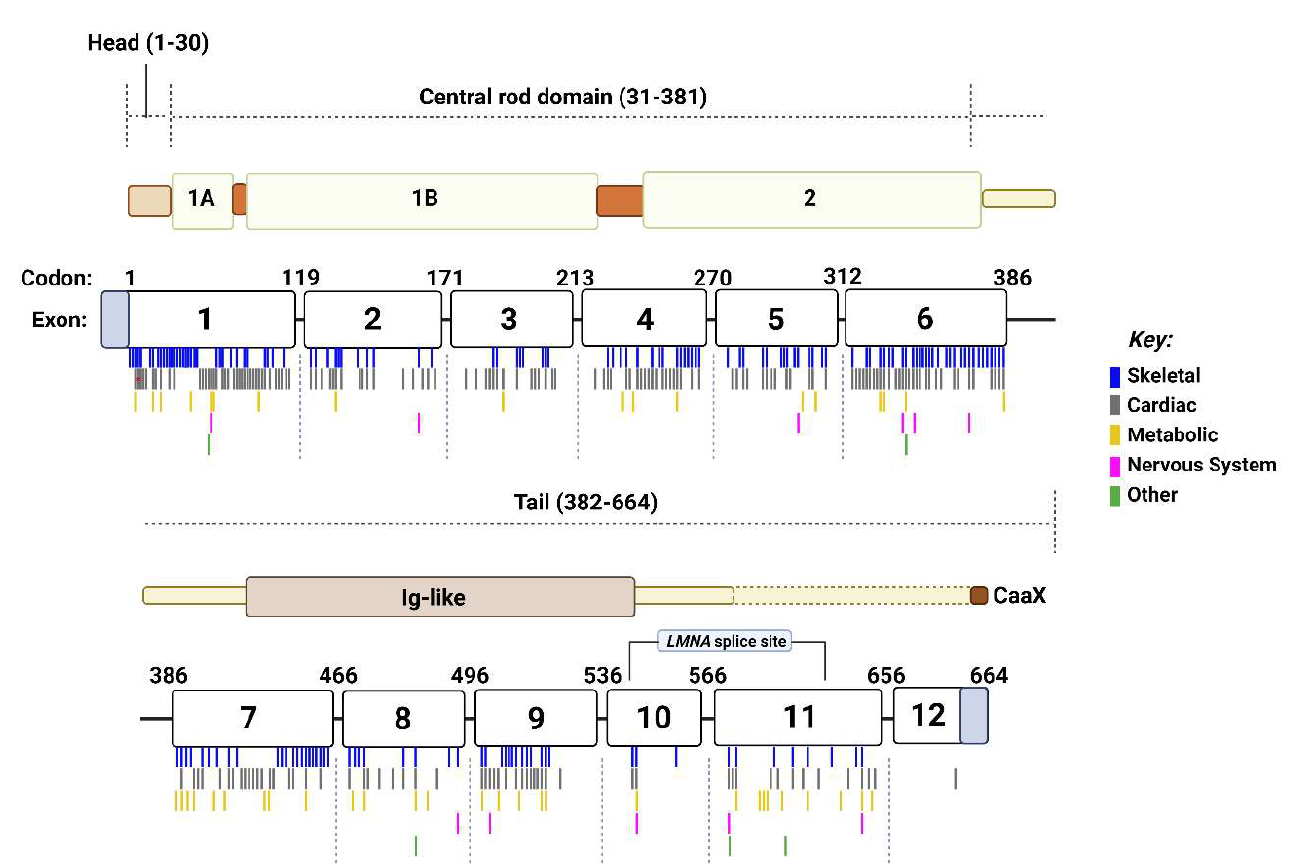
Figure 4. The structure of the LMNA gene and protein product lamin A. LMNA encodes lamin A/C. Lamin C is produced via a splice site located at intron 10 and therefore it’s C-terminus differs to lamin A. LMNA consists of 12 exons. Each coding region LMNA mutation was assigned to a disease category based on the disease type it caused. If it caused more than one type of disease, it was considered in multiple categories. These mutations were then marked below the LMNA gene at the appropriate codon, in a colour that corresponds to its related disease type(s). Above the LMNA gene is the structure of lamin A, consisting of a head, central rod and tail domain. Created with